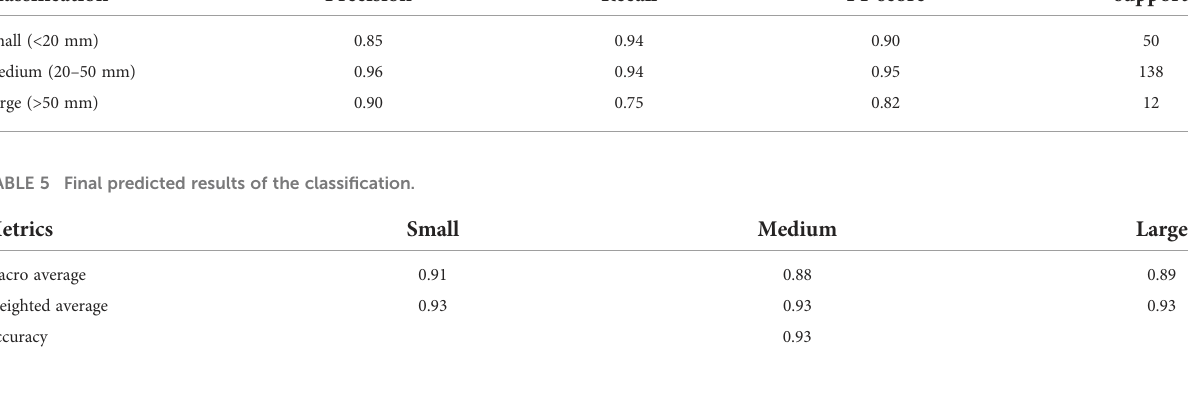
TABLE 6 Comparison of the volume and mean intensity between cystic or necrotic components and lesions.